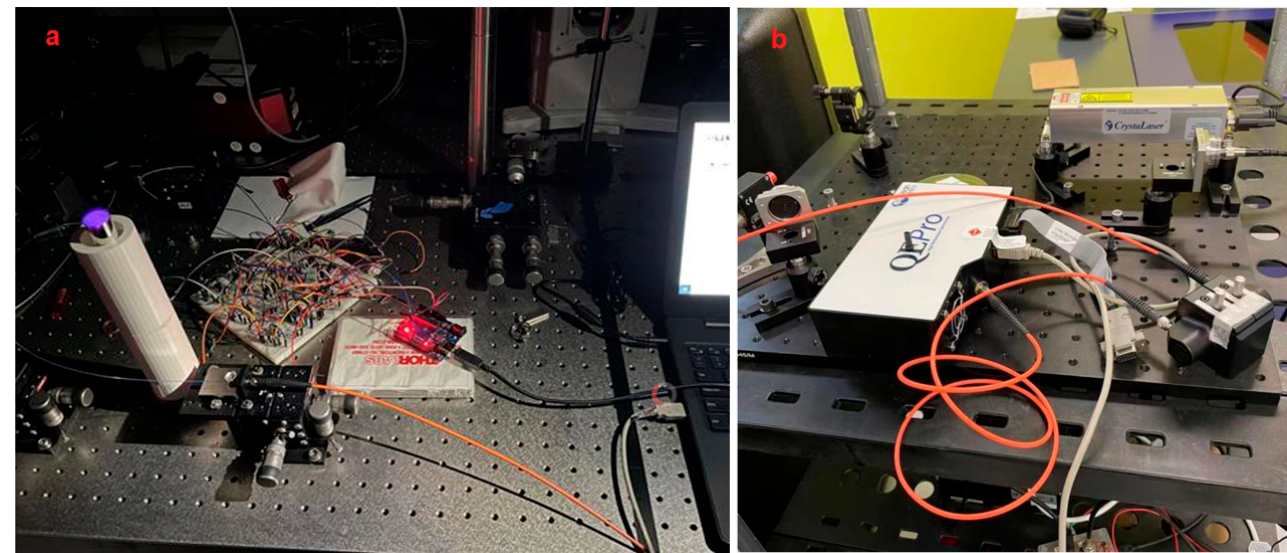
Figure 9. Real picture of the sensor taken under dark environment ( a ), the fluorescence receiver with optical fiber connected ( b